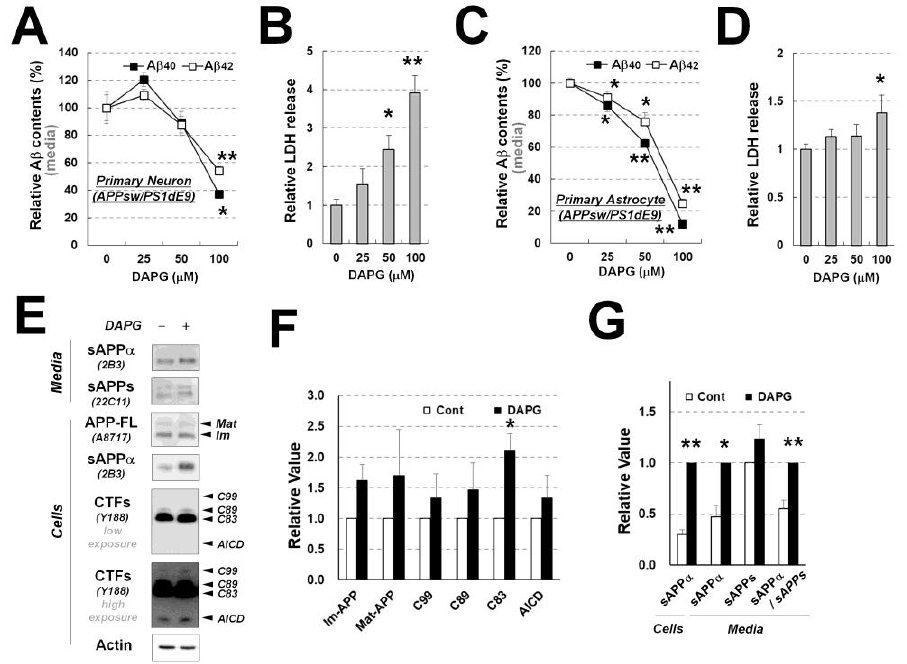
Figure 5. Examination of DAPG-mediated decrease in Aβ levels and toxicity in primary neurons and astrocytes from APPsw/PS1dE9 transgenic mice. ( A , B ) ELISA analysis of Aβ 1–40 and Aβ 1–42 levels ( A ) and LDH release analysis ( B ) in the culture medium from primary neurons isolated from APPsw/PS1dE9 transgenic mice. Neurons were treated with 0–100 μM DAPG for 8 h. ( C ) ELISA analysis of Aβ 1–40 and Aβ 1–42 levels ( C ) and LDH release analysis ( D ) in the culture medium from primary astrocytes isolated from the transgenic mice. Astrocytes were treated with 0–100 μM DAPG for 8 h. ( E ) Immunoblots analysis of APP processing in primary astrocytes and culture medium after 8 h treatment with 30 μM DAPG. The levels of sAPPα and sAPPs in the medium and immature (Im) and mature (Mat) APP-FL, sAPPα, CTFs, AICD, and actin in cells were examined. ( F , G ) Densitometry analysis of markers in primary astrocytes ( F ) and sAPPs in the cells and medium ( G ) from immunoblots presented in ( E ). Values in all graphs are presented as means SEMs (n = 3). Statistical significances of the differences between treated groups and untreated controls were determined using Student’s t-test (* p < 0.05, ** p < 0.01). 3.6. Intrahippocampal Injection of DAPG Reduces Triton-Soluble Aβ and Increases sAPPα Levels in APPsw/PS1dE9 Transgenic Animal Models To determine the in vivo effects of DAPG, 20 mg/kg DAPG were injected intraperitoneally into APPsw/PS1dE9 transgenic mice daily for 9 days, and a Morris water maze test was performed (Figure S1A). DAPG treatment had no impact on the spatial memory decline of the transgenic mice. DAPG also did not affect APP processing, including APP-FL, sAPPα, CTFs formation, in the hippocampus of transgenic mice (Figure S1B,C). In addition, computational simulation of DAPG penetrance of the BBB showed that DAPG could not cross the BBB (Figure 1A), indicating that ineffectiveness of systemic treatment of DAPG may be due to BBB impermeability. As an alternative to investigated DAPG in vivo effects, DAPG was injected directly into the hippocampus of transgenic mice (Figure 6B) and Aβ levels in Triton-soluble and Triton-insoluble (or GuHCl-soluble) fractions from the contralateral control and ipsilateral DAPG-injected hippocampi were analyzed to determine the amount of soluble (or initially secreted Aβ) and insoluble (or accumulating extracellular Aβ that aggregated into amyloid plaques) Aβ, respectively (Figure 6C,D). Compared with the amounts found in control hippocampi, Triton-soluble Aβ 1–40 levels were significantly reduced, and Aβ 1–42 amounts were slightly, albeit not significantly ( p = 0.064), decreased by DAPG injection in the hippocampus. However, DAPG injection did not affect Aβ content of the Triton- insoluble fraction, suggesting that DAPG affected early events of Aβ accumulation in